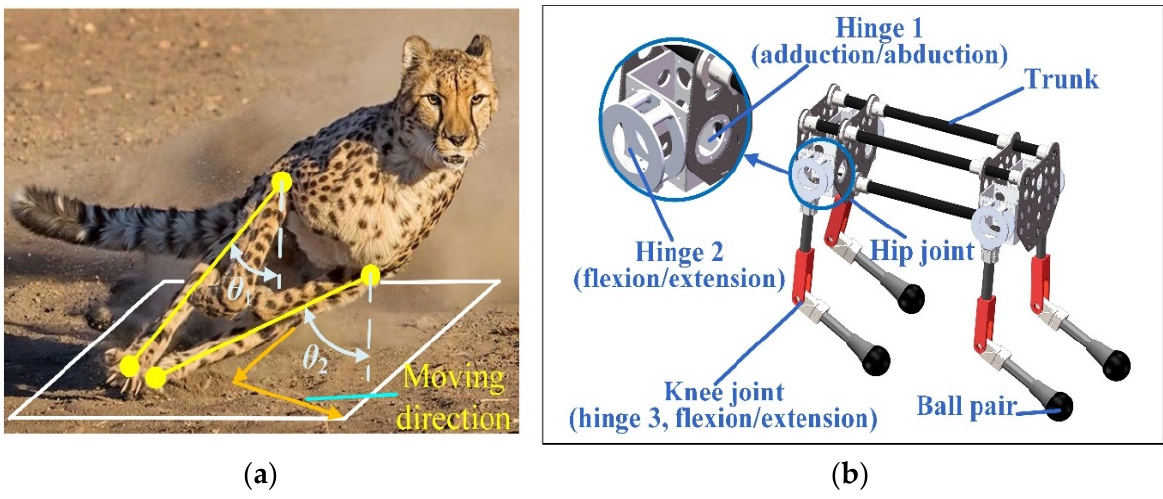
Figure 1. ( a ) Moment when the cheetah changes its movement direction during running. The legs of the cheetah have larger adduction/abduction angles than the cheetah moving in one plane. ( b ) 3D model of the cheetah-inspired quadruped robot. The hip joint has 2 DOFs, and the knee joint has 1 DOF.